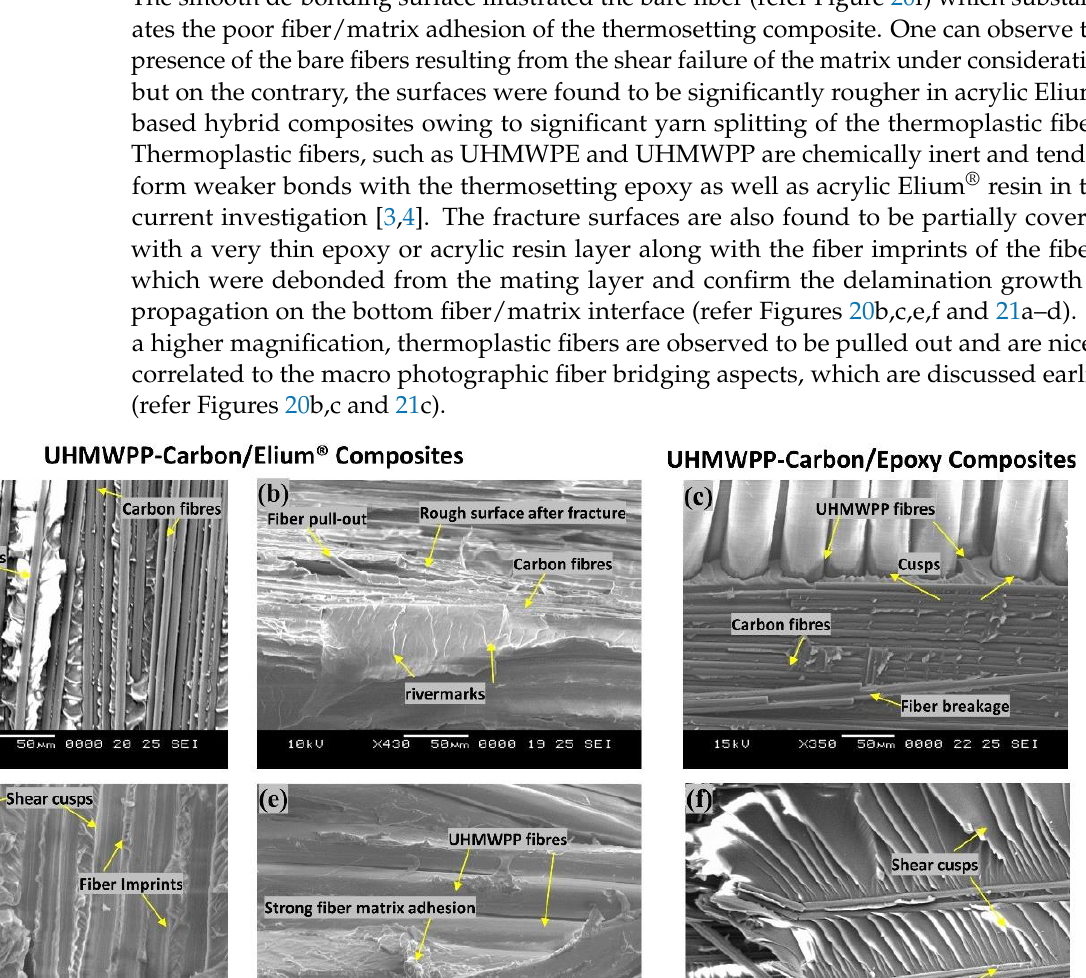
Figure 21 . Surface morphological images of fractured surfaces of composites using Scanning Elec- tron Microscopic approach of ( a , c ) Carbon_UHMWPE/ Elium ® composite ( b , d ) Car- bon_UHMWPE/Epoxy composite under Mode II loading .